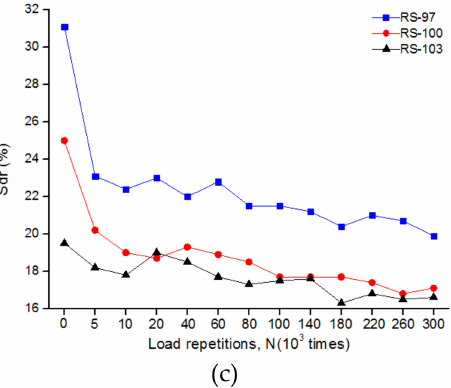
Figure 9. Change of texture parameters with load repetitions. ( a ) MTD; ( b ) Sq ; and ( c ) Sdr .